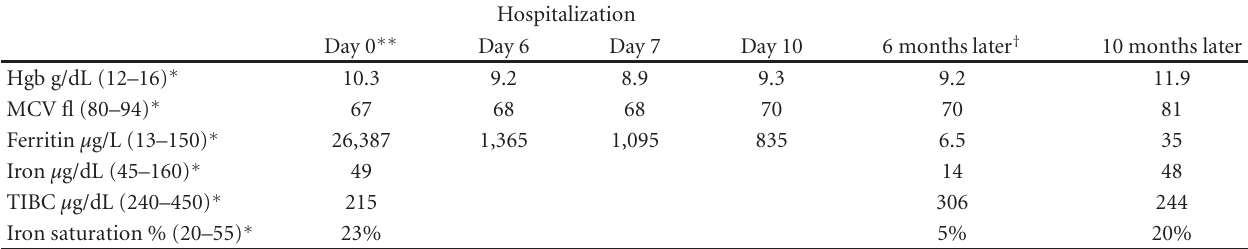
Table 1: Hematological